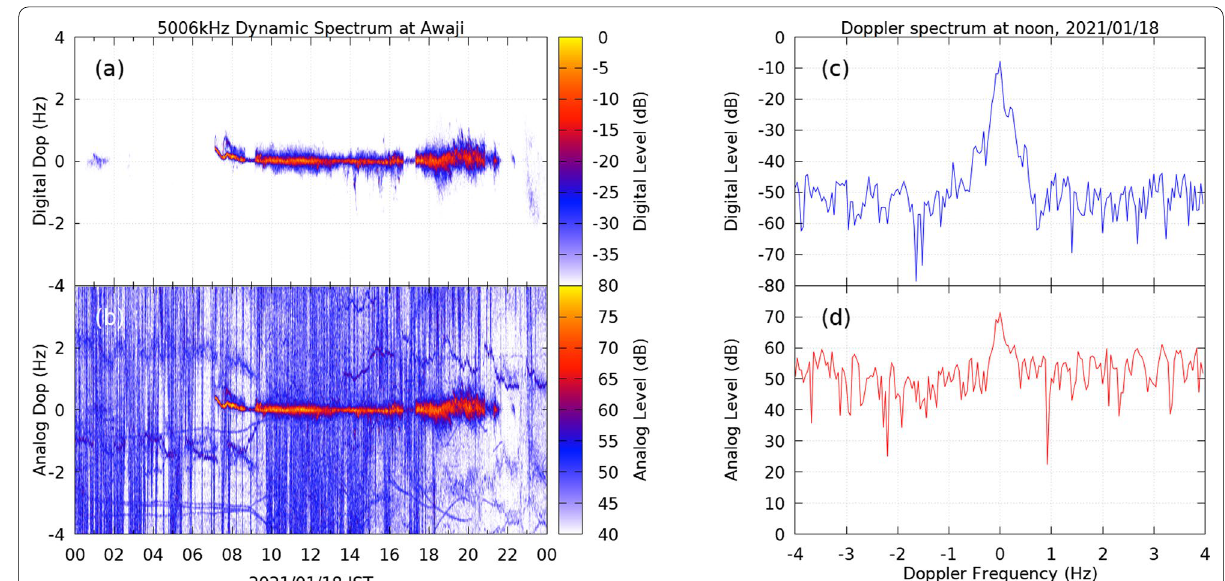
Fig. 9 (Left) The Dynamic spectrum of the radio wave at the frequency of 5006 kHz (JG2XA). The spectrum were observed on 18 January 2021 using the a digital and b analog receivers in Awaji. (Right) the signal intensities obtained by c digital and d analog receivers at 12 JST on 18